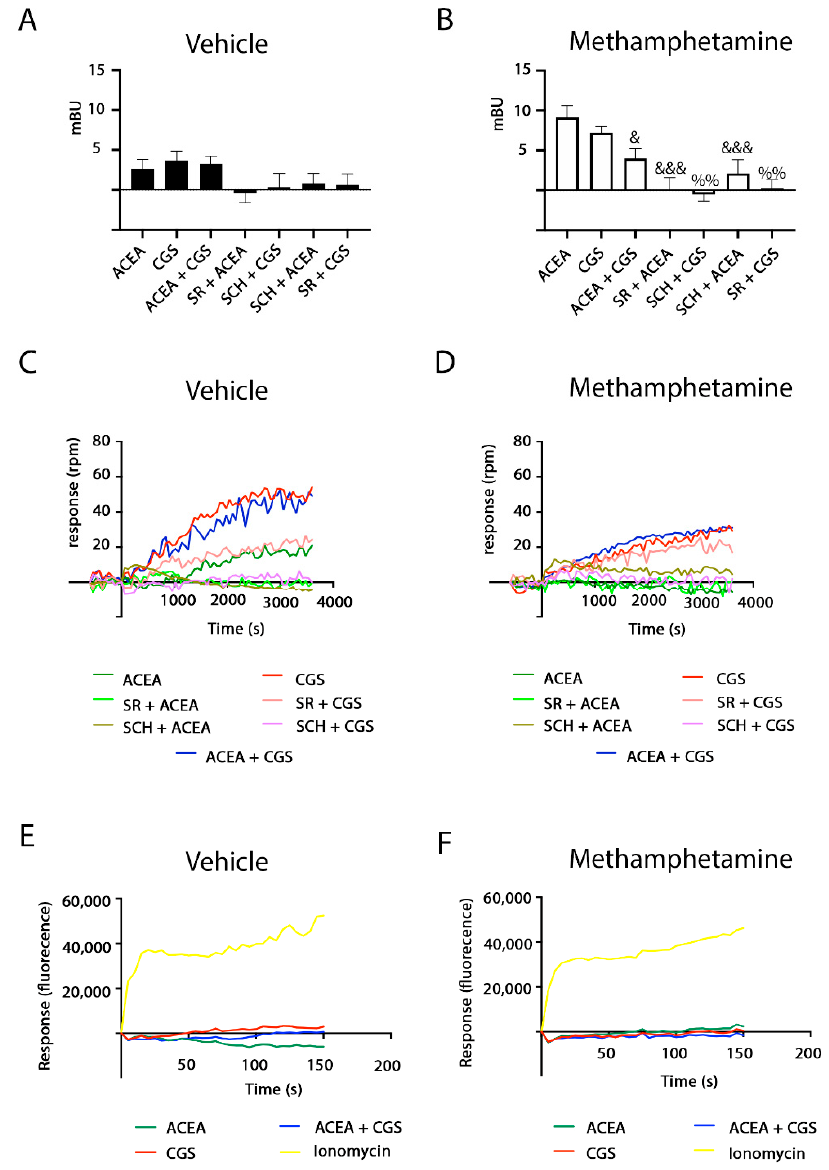
Figure 3. Methamphetamine effect on A 2A –CB 1 Het functionality: ß-arrestin-2 recruitment, dynamic mass redistribution (DMR) and Ca 2+ mobilization. HEK-293T cells transfected with cDNAs corre- sponding to A 2A R-YFP (0.4 µ g), CB 1 R (0.3 µ g) and ß-arrestin-2-Rluc (0.5 µ g) ( A , B ) or with A 2A R (0.5 µ g), CB 1 R (0.6 µ g) ( C , D ) and 6GCaMP calcium sensor (1.5 µ g) ( E , F ) were treated (30 min) with vehicle ( A , C , E ) or with 1 µ M methamphetamine ( B , D , F ) and subsequently treated with 500 nM of the A 2A R antagonist SCH 58261 (SCH) or with 500 nM of the CB 1 R antagonist SR 141716A (SR). Receptors were activated using 100 nM of the A 2A R agonist CGS 21680 (CGS), with 200 nM of the CB 1 R agonist ACEA or both. In ( E , F ), a portion of the cells were stimulated with 1 µ M ionomycin as a positive control. The BRET data resulting from ß-arrestin-2 recruitment ( A , B ), time-dependent DMR representative traces ( C , D ) and time-dependent representative traces of cytoplasmic Ca 2+ levels ( E , F ) are shown. In ( A , B ), BRET is expressed as milli BRET units (mBU) and is given as the mean ± SEM of six different experiments grouped by amount of BRET acceptor. A one-way ANOVA followed by Bonferroni multiple comparison post hoc test showed a significant effect over 100% (& p < 0.05, &&& p < 0.001 versus ACEA condition; %% p < 0.01 versus CGS condition).